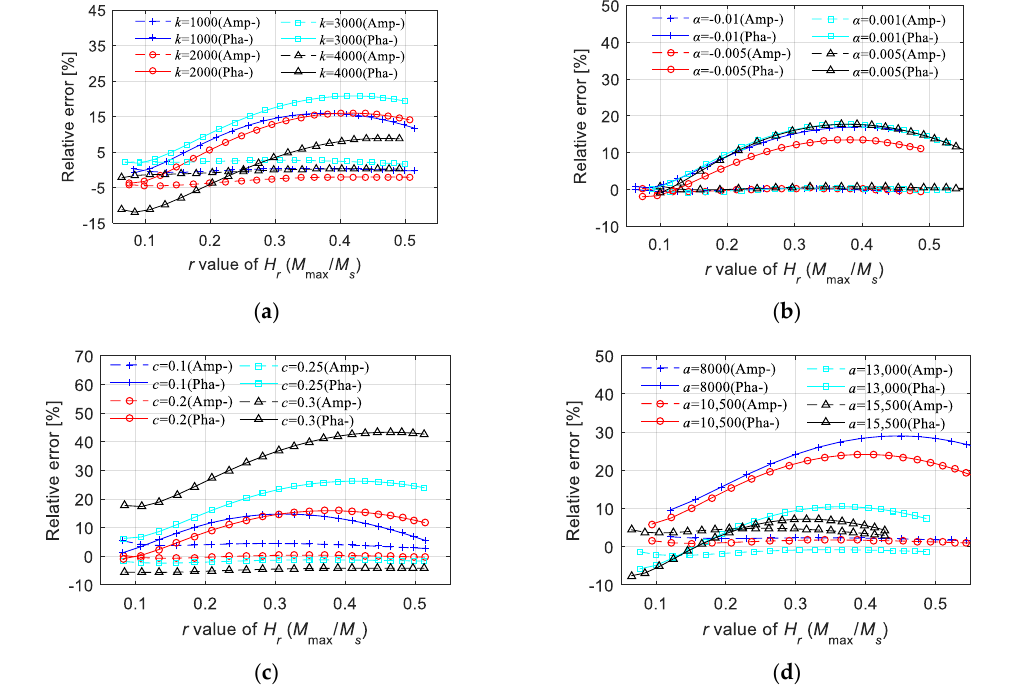
Figure 11. Relative errors of the 1st LTI system model in calculating the magnetization amplitude and equivalent phase lag under univariate change condition: ( a ) k ∈ [1000 kA/m, 4000 kA/m], a = 12 kA/m, c = 0.2, α = − 0.001; ( b ) a ∈ [8000 kA/m, 15,500 kA/m], k = 2 kA/m, c = 0.2, α = − 0.001;